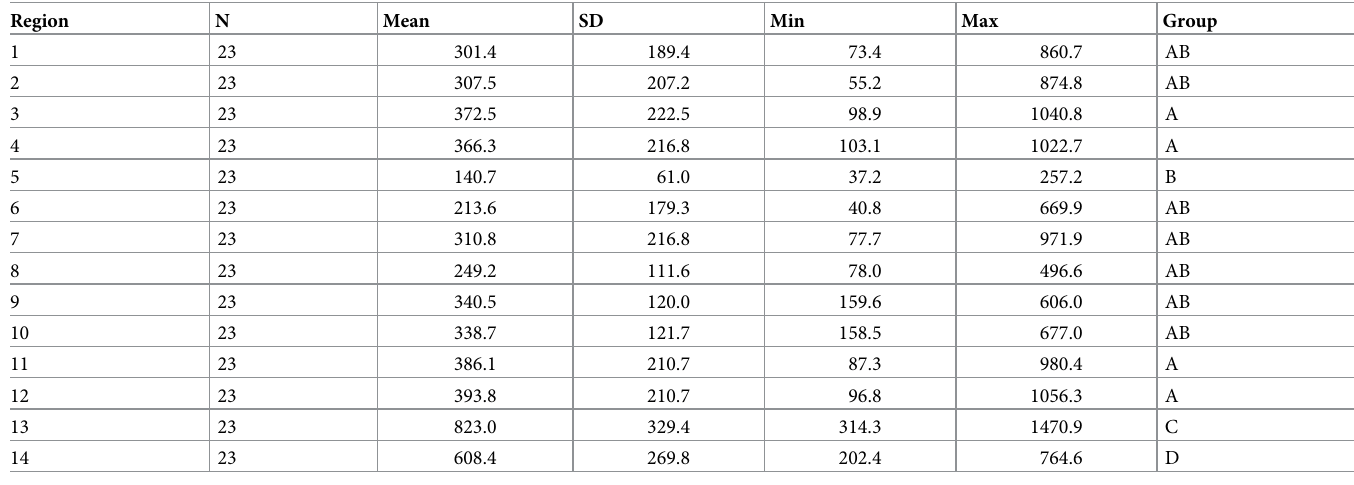
Letters identify statistical